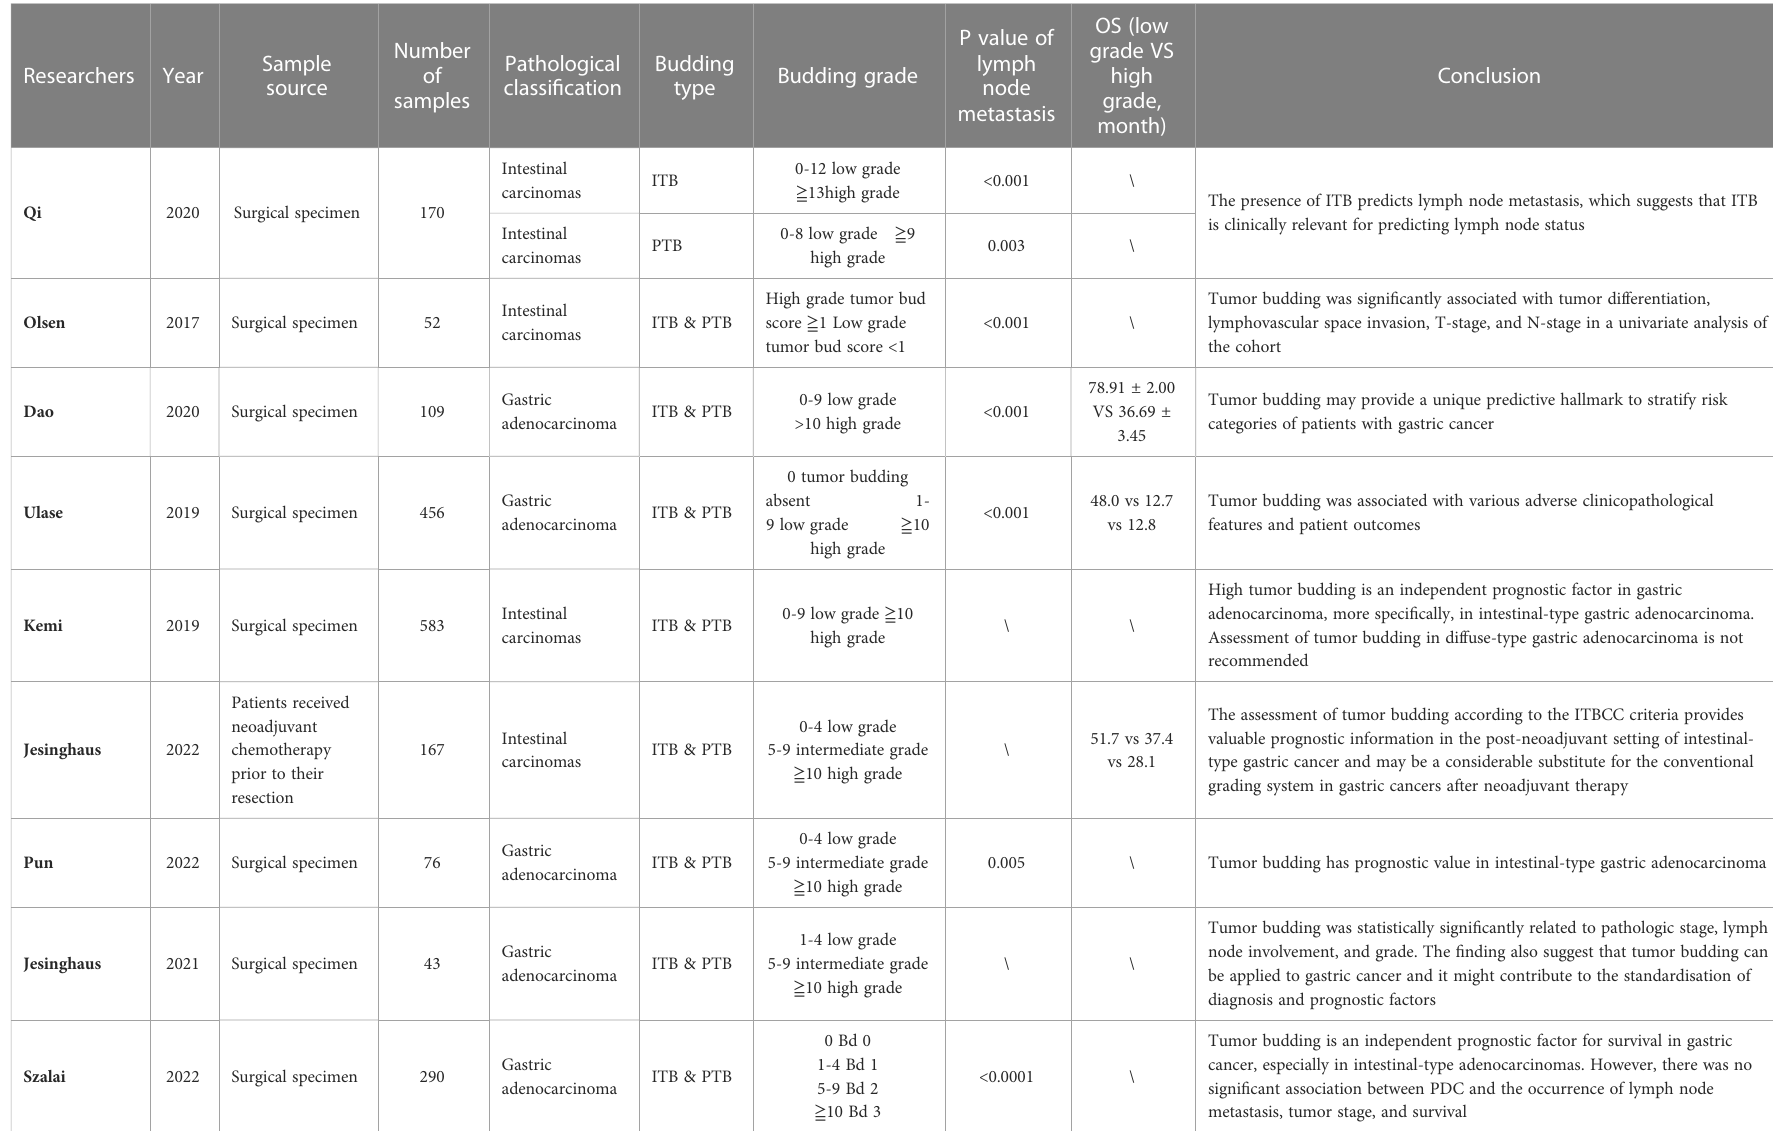
TABLE 2 Results of tumor budding in advanced gastric